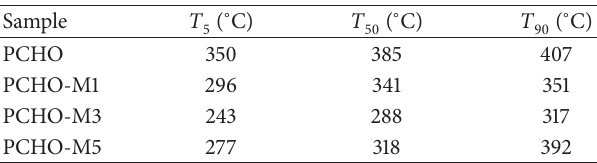
Table 1: Thermal degradation temperatures of pure polymer and